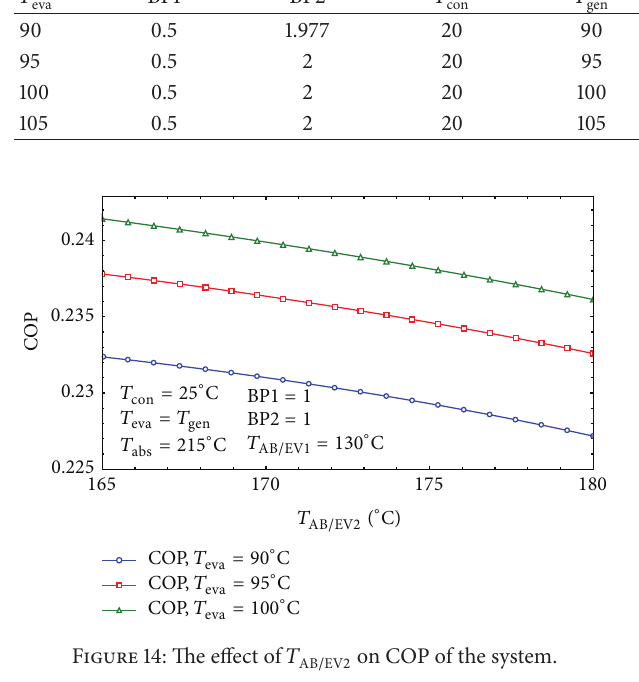
of the weak solution and consequently the flow ratio (𝑓) increases resulting in a decrease in the absorber heat capacity.